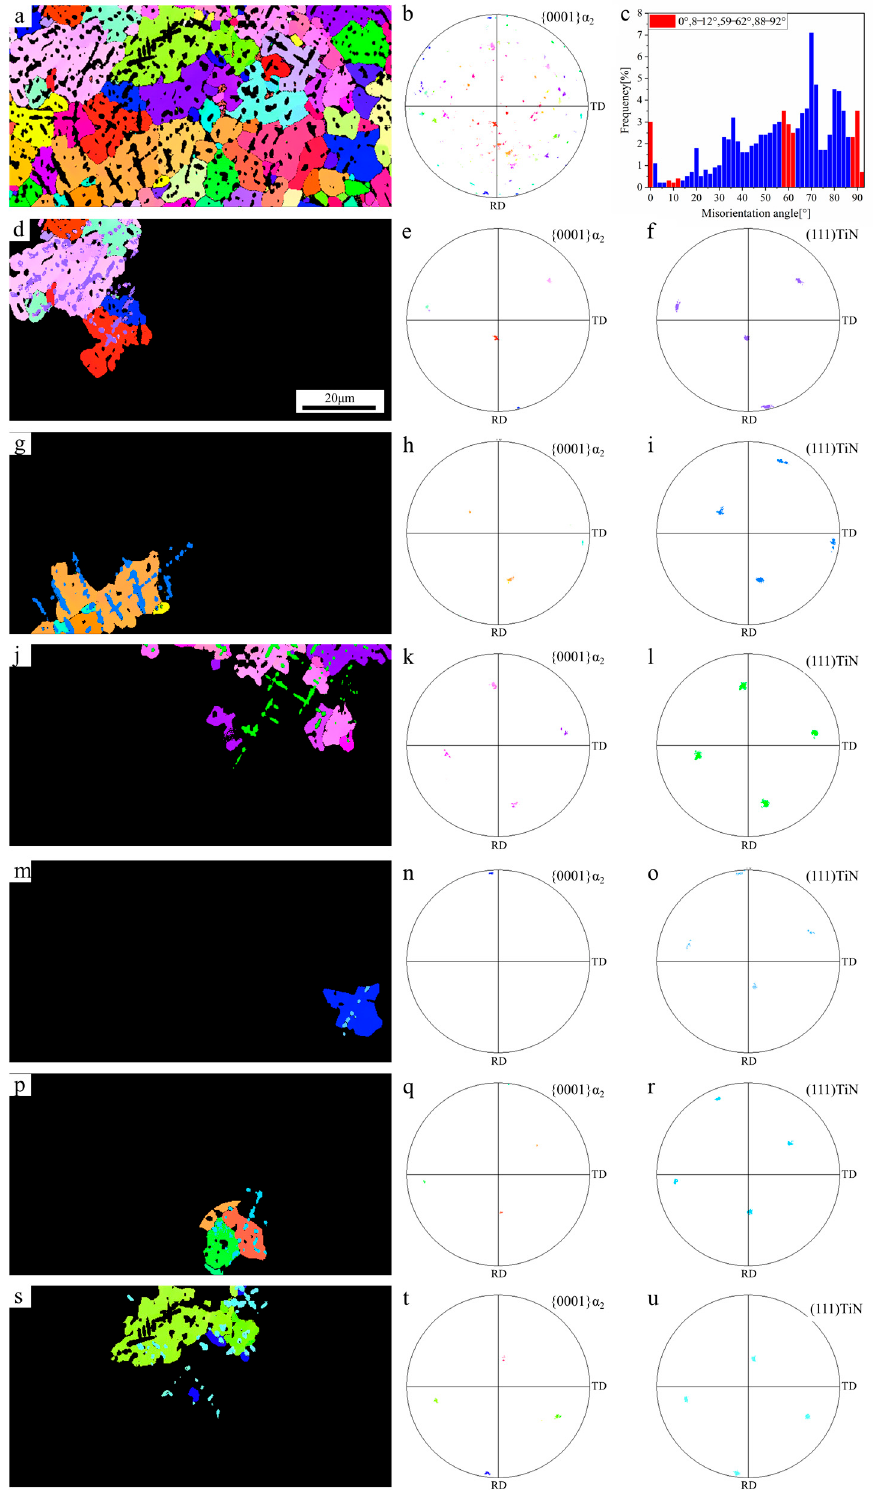
Figure 5. EBSD measurements of TiN and α 2 phase of the welding zone of 2# sample: ( a ) α 2 texture map; ( b ) α 2 phase pole figure; ( c ) corresponding misorientation angles of α 2 phase; ( d , g , j , m , p , s ) texture map of TiN and α 2 phase of sections 1–6, ( e , h , k , n , q , t ) pole figure of (0001) α 2 in each section; ( f , i , l , o , r , u ) pole figure of (111) TiN in each section.